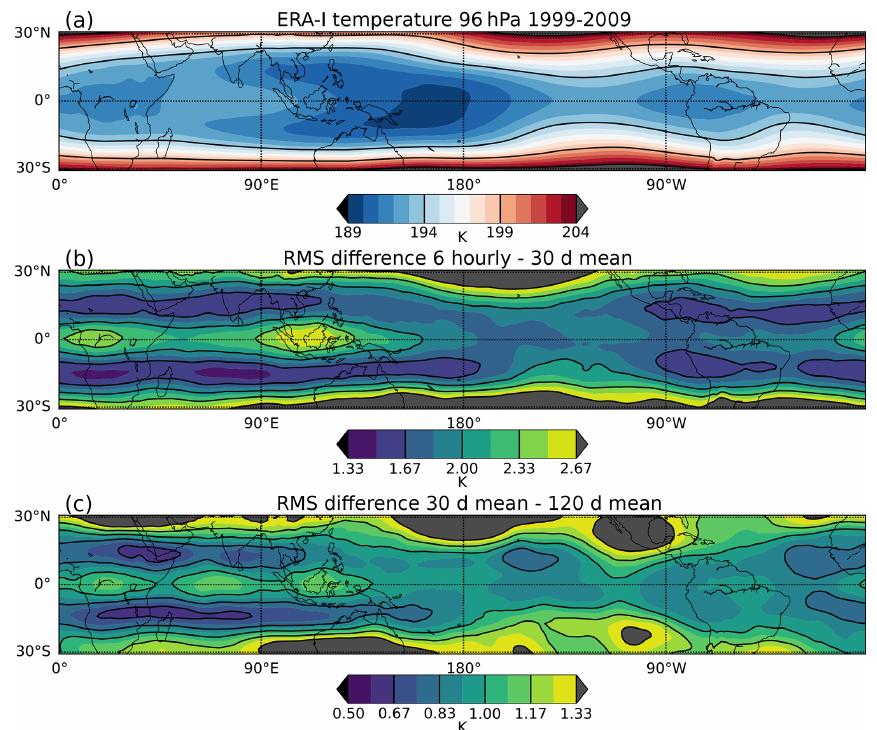
Figure 6. 1999–2009 ERA-Interim temperatures at 96hPa. (a) Time mean, (b) root-mean-square difference between 6-hourly and 30d rolling means, and (c) root-mean-square difference between 30 and 120d rolling means. Note the difference in colour scale between panel (b) and (c) .